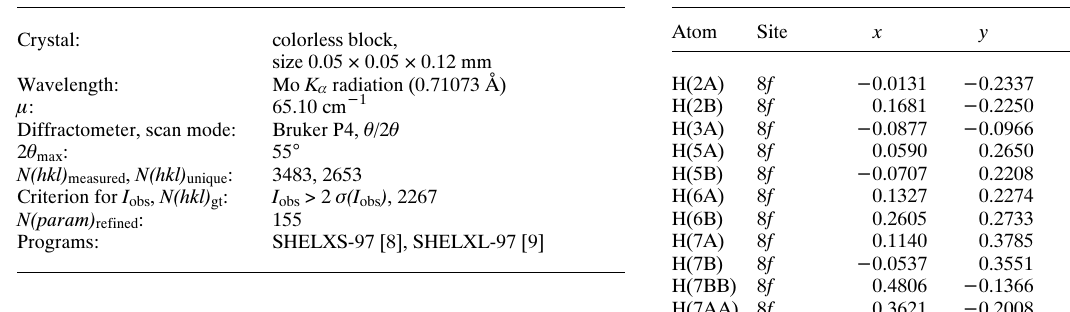
Table 1. Data collection and